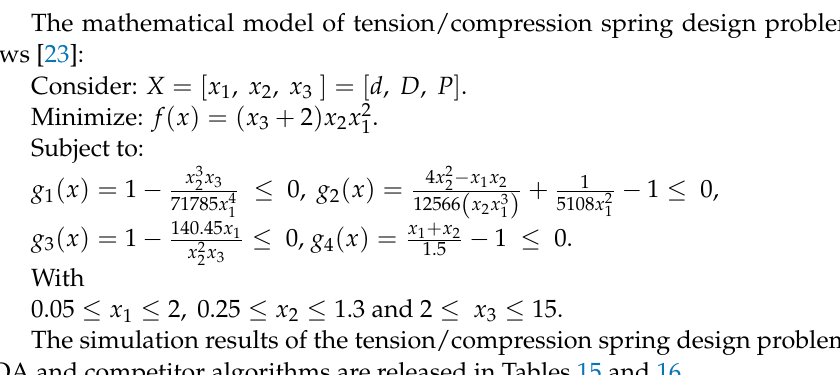
Table 15. Performance of optimization algorithms on the tension/compression spring design prob- lem. Algorithm